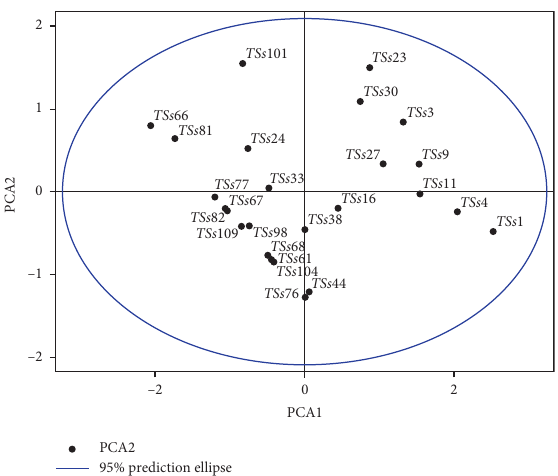
Figure 5: Clustering analysis of proximate contents of processed samples. TSs: Tropical Sphenostylis stenocarpa .